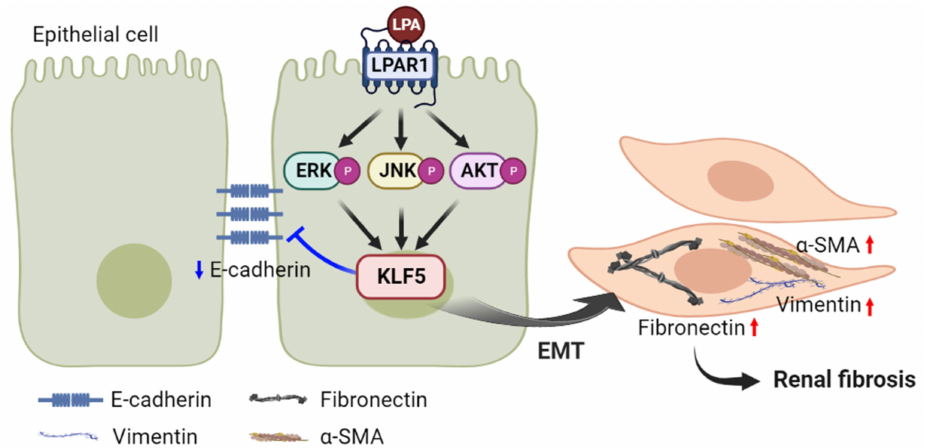
Figure 8. Schematic diagram of the mechanism by which LPA induces KLF5-mediated EMT and fibrotic responses via LPAR1/MAPK-AKT signaling in renal tubular epithelial cells. Created with BioRender.com. Red and blue arrows indicate upregulated and downregulated responses,